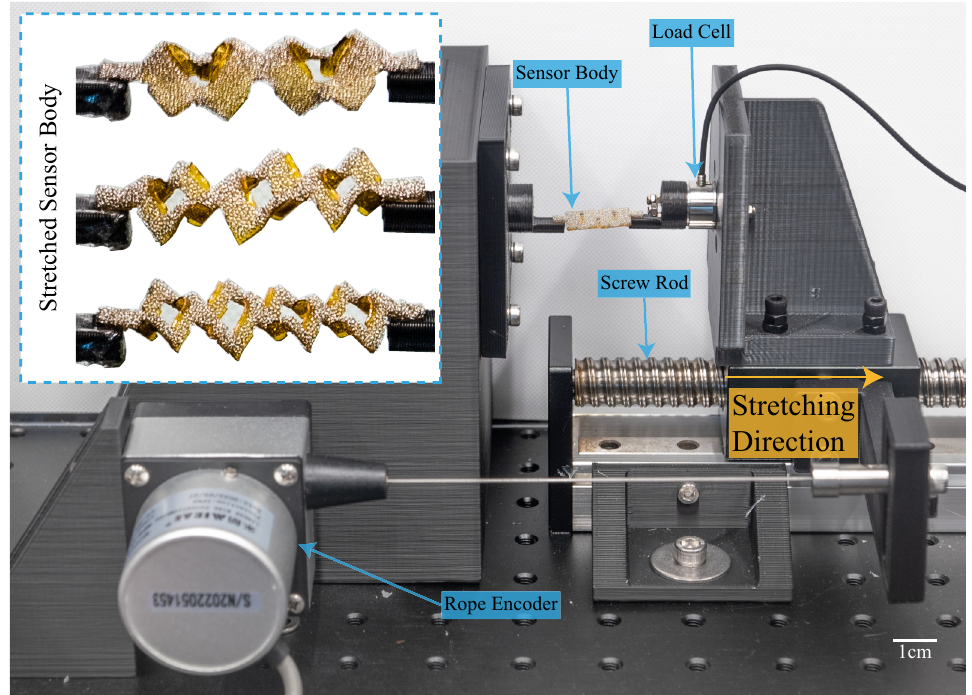
Figure 6. Experimental setup for sensor stretching experiment. Photos of a stretched sensor are shown in the top left corner. A scale bar with 1 cm is